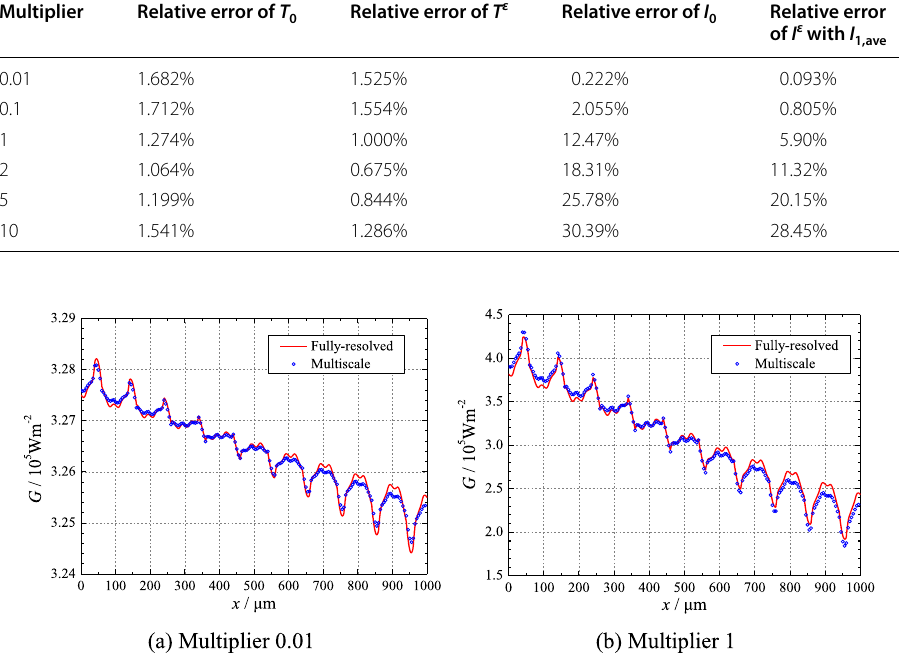
Fig. 7 The incident radiation profiles of the fully‑resolved simulations and the multiscale simulations on line y 0.05 mm with different multipliers of the absorption and scattering coefficients =